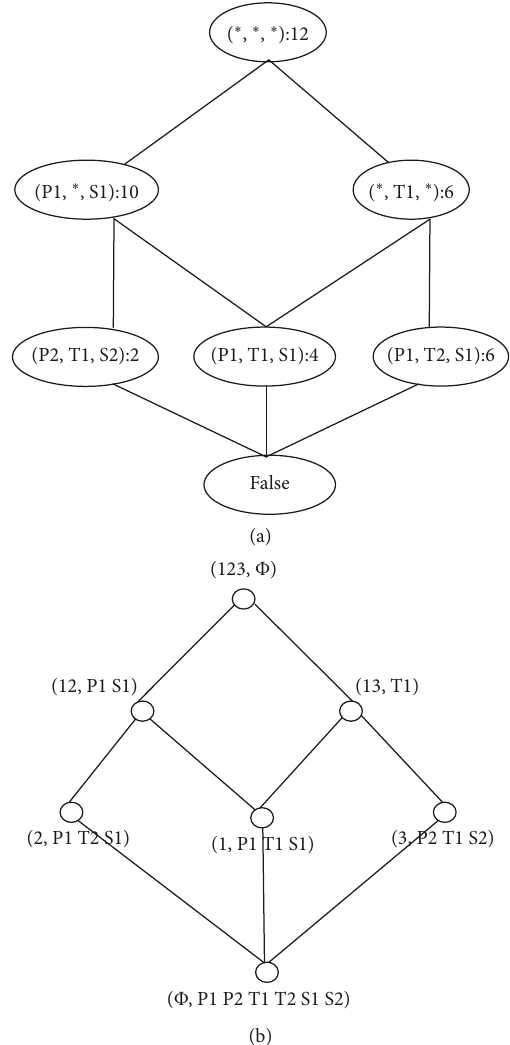
Figure 12: Data cube lattice and the corresponding concept lattice. (a) Data cube lattice. (b) Concept